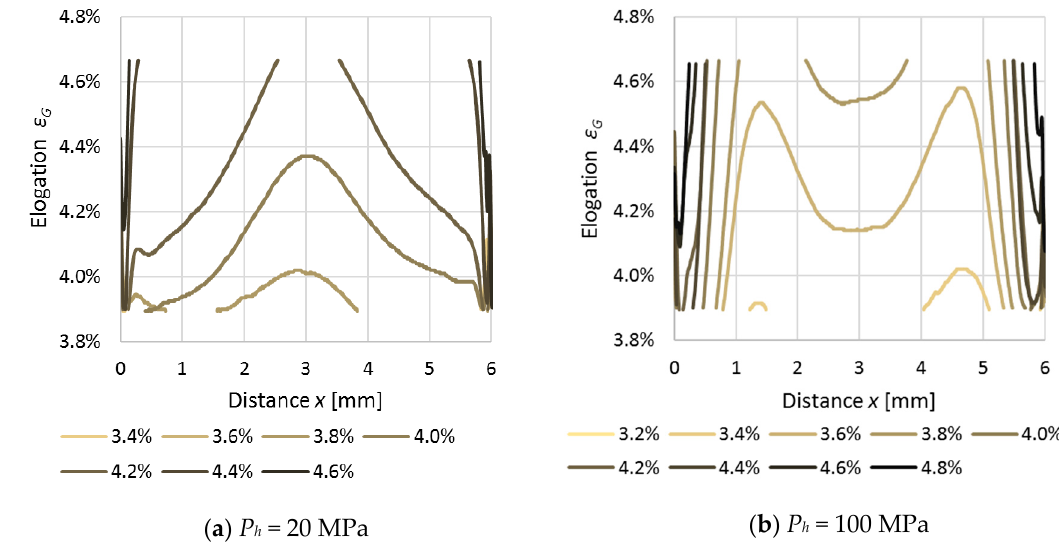
Figure 6. Elongation evaluated from grey scale ( ε G ). Samples produced with di ff erent holding Figure 6. E longation evaluated from grey scale ( ɛ G ). Samples produced with different holding pressures: ( a ) 20 MPa and ( b ) 100 MPa.